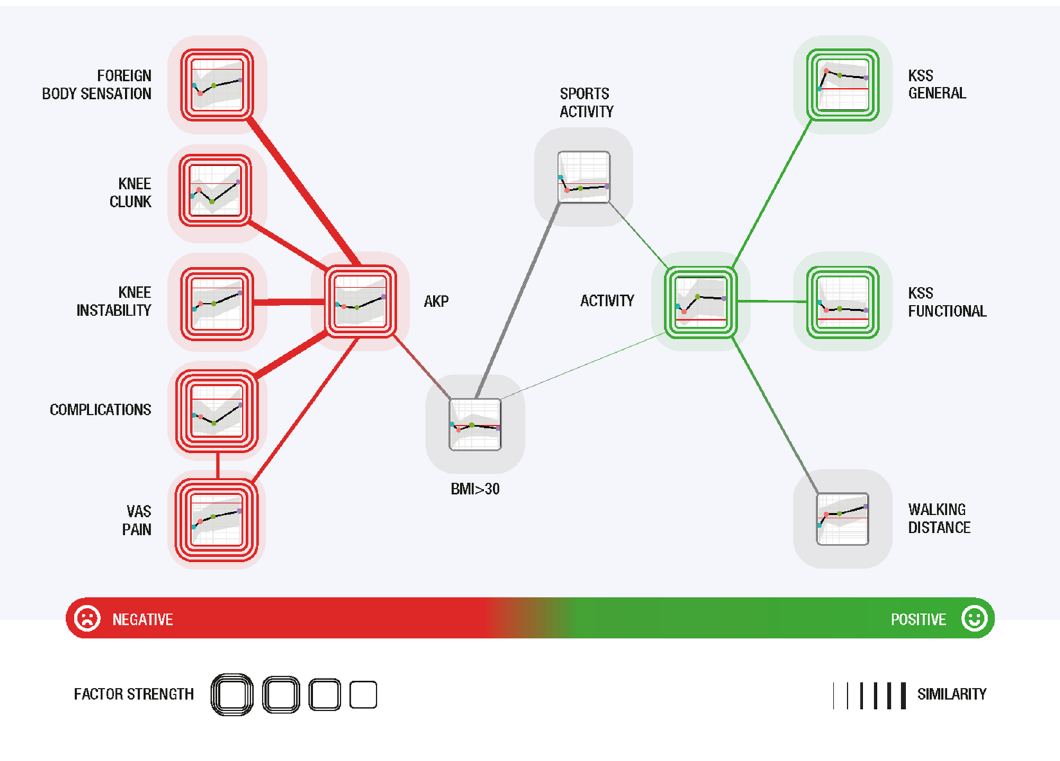
Figure 4. Odds-ratio network for combinations of postoperative factors contributing to satisfaction 2 years after TKA in men. The right cluster (green) combines factors associated with satisfaction, the middle cluster network (grey) includes factors that have little influence on satisfaction (neutral effect) and the left cluster (red) combines factors associated with not being fully satisfied. The size of a network vertex corresponds to its similarity to the neighbouring vertices (=